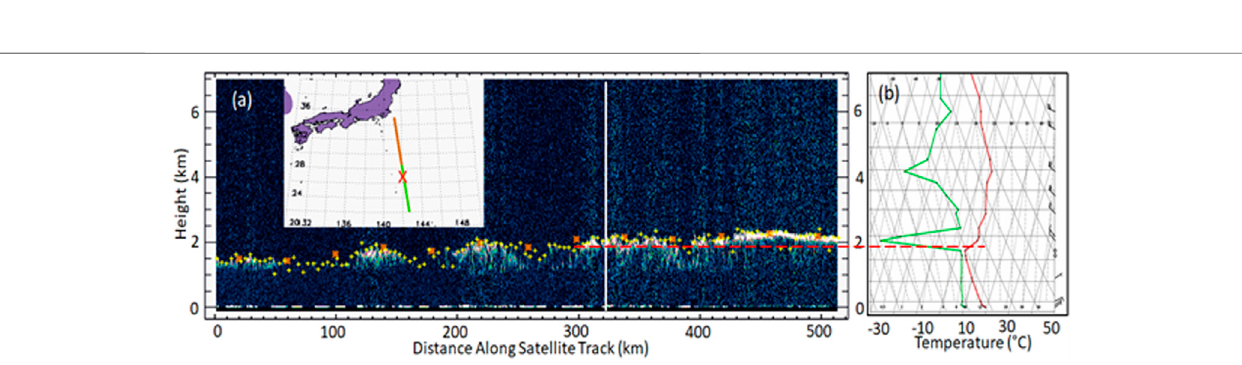
Frontiers in Remote Sensing |